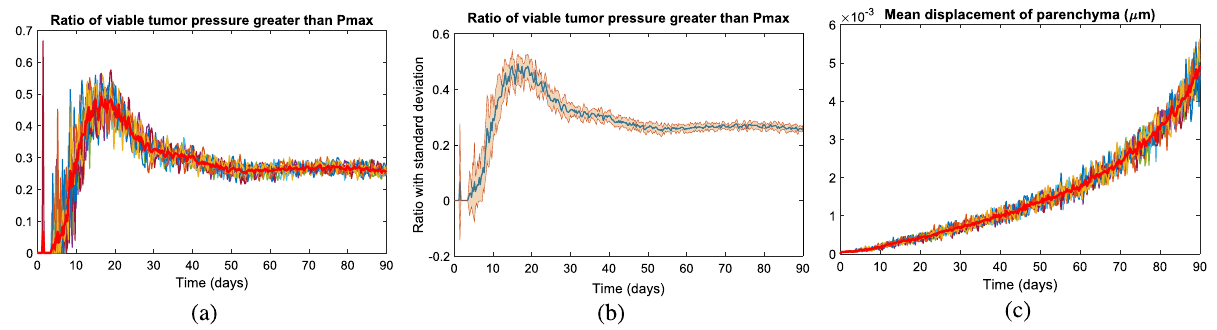
Figure 7. Longitudinal changes in pressure over 90 days. In ( a , b ) we plot the fraction of tumor cells exceeding the arrest threshold, showing 10 individual profiles ( a ) and the average and standard deviation of 10 runs ( b ). ( c ) plots the mean parenchyma displacement. Here, r E = 0.05 (1/min), r P = 0.0005 (1/min) and d max = 0.75 µ m .